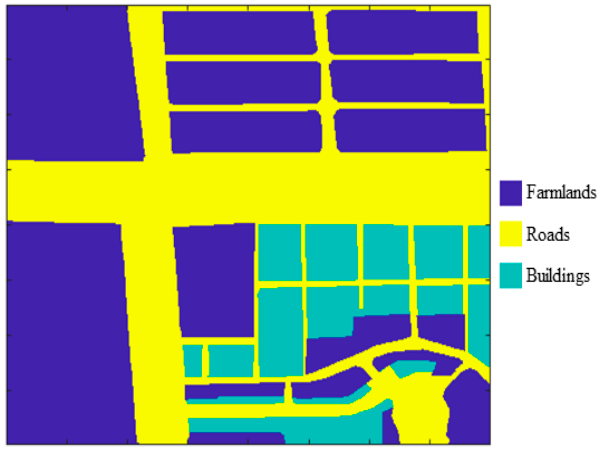
Figure 9. Groud truth map of Dongying City Dataset.